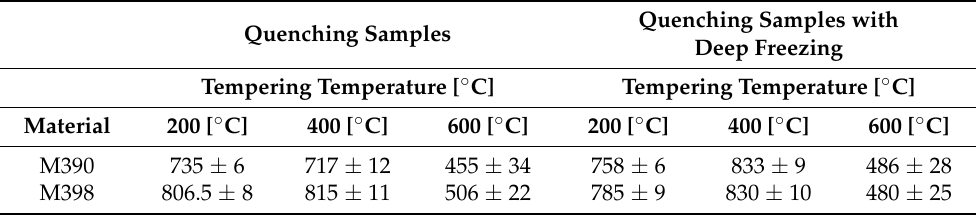
Table 3. Comparison of hardness of HV10 of materials M390 and M398 after tempering. Quenching